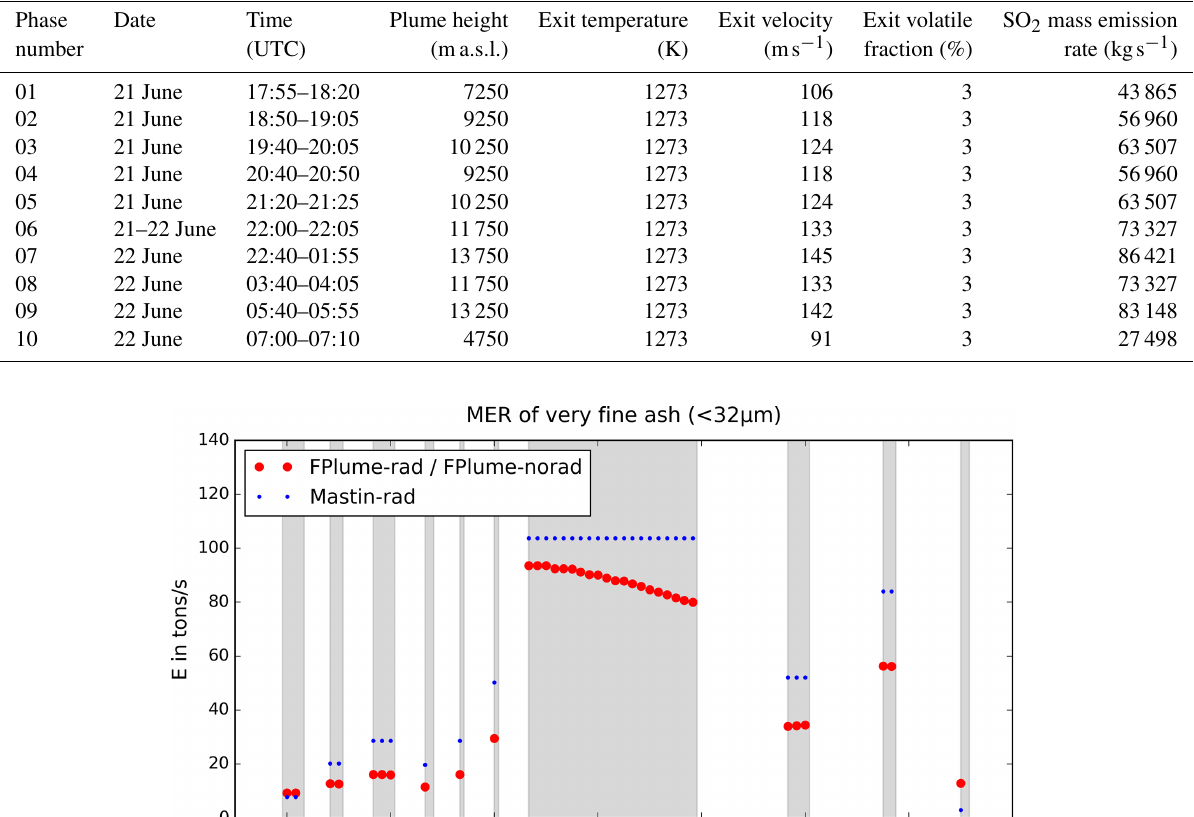
Table 1. Model setup and input parameters for the individual eruption phases (FPlume-rad). The definition of the phases and plume heights above sea level (a.s.l.) are based on GOES-17 satellite observation as described in Sect. 2.3.2. The exit conditions are based on typical values of basaltic eruptions as described in Sect. 2.3.1. The SO 2 mass emission rate is based on an observational estimate of the total SO 2 mass following the 2019 Raikoke eruption from Muser et al. (2020), which was distributed over the individual phases with Eq. (3). This table only shows the values that are predefined and fixed for the individual phases. The temporally varying MER of the very fine ash, which is derived with FPlume and the relationship by Gouhier et al. (2019) and which is released into ICON-ART, is shown in Fig. 2.